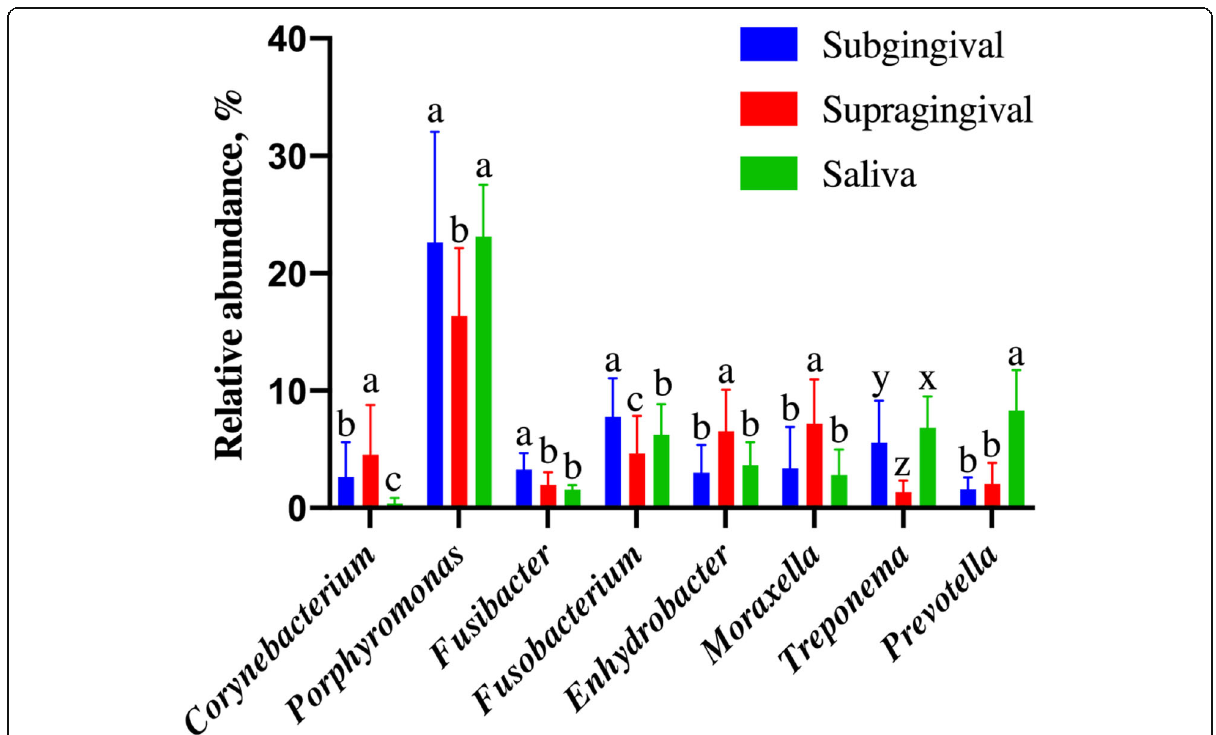
Fig. 4 Predominant oral bacterial genera (relative abundance, %) present in plaque (supragingival and subgingival plaque) and saliva samples from healthy adult dogs. a-c Means with different superscripts within a genera differ by Tukey's test ( p <0.05). w-z Means with different superscripts within a genera differ by Wilcoxon's test ( p